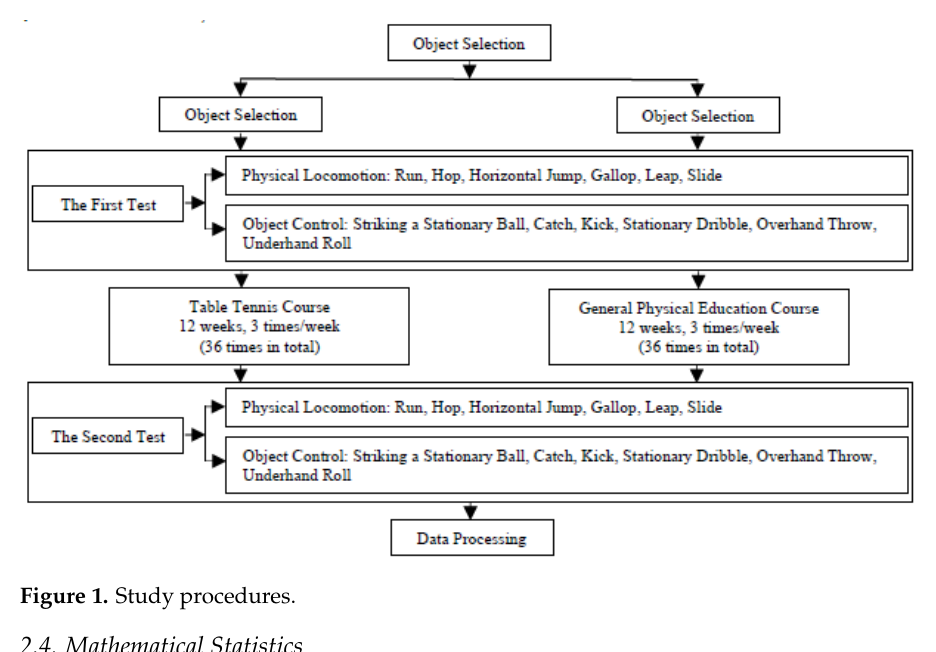
Figure 1. Study procedures.